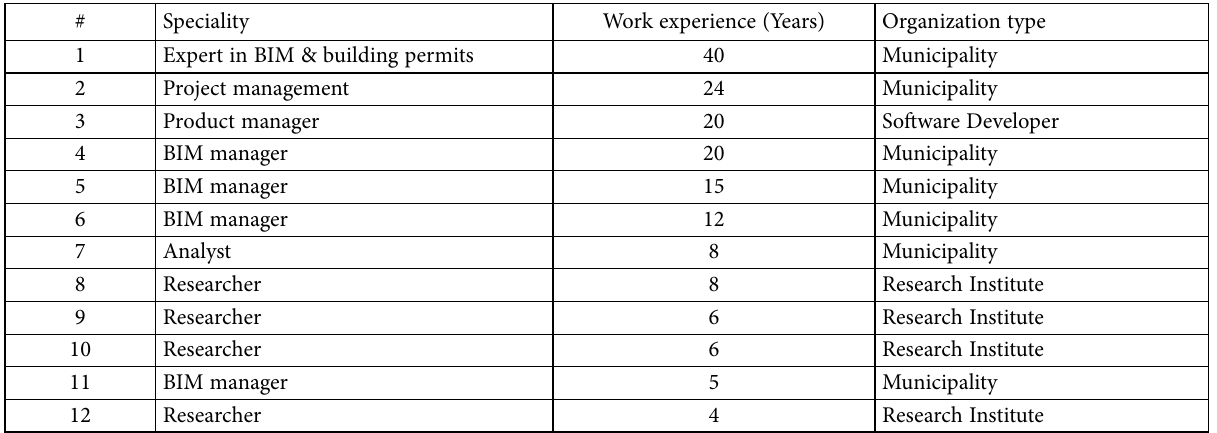
Table 4. Profiles of